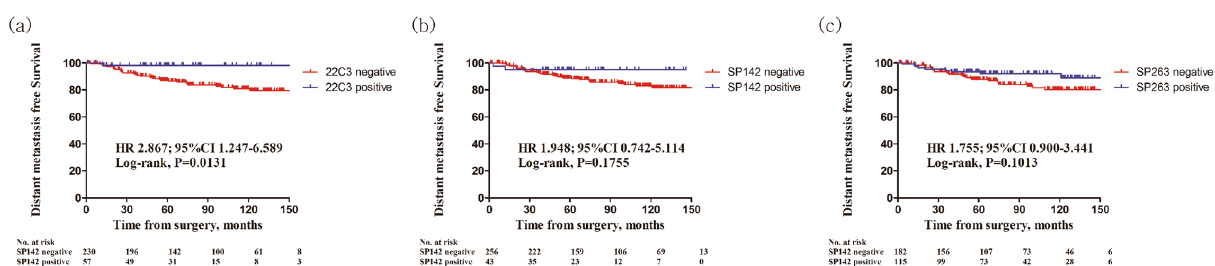
Figure 4. Kaplan–Meier survival curves of distant metastasis-free survival (DMFS) in relation to PD-L1 expression based on PD-L1 antibody-IHC assays in patients with breast cancer. ( a ) Patients with negative PD-L1 expression based on the 22C3-IHC assay were associated with poor DMFS (HR 2.867, 95% CI 1.247–6.589, P = 0.0131, log-rank test). ( b , c ) DMFS did not significantly differ based on SP142- and SP263-IHC assay